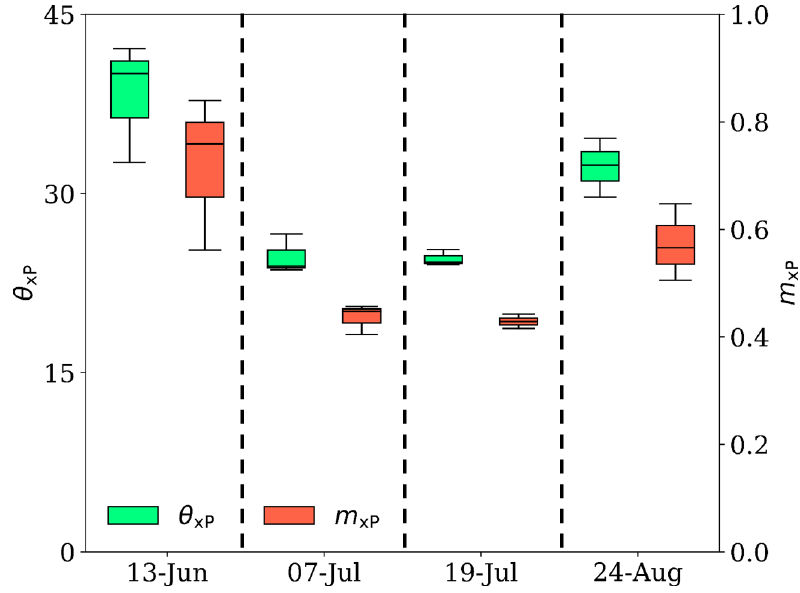
Figure 7. Temporal variation of θ xP and m xP over the canola